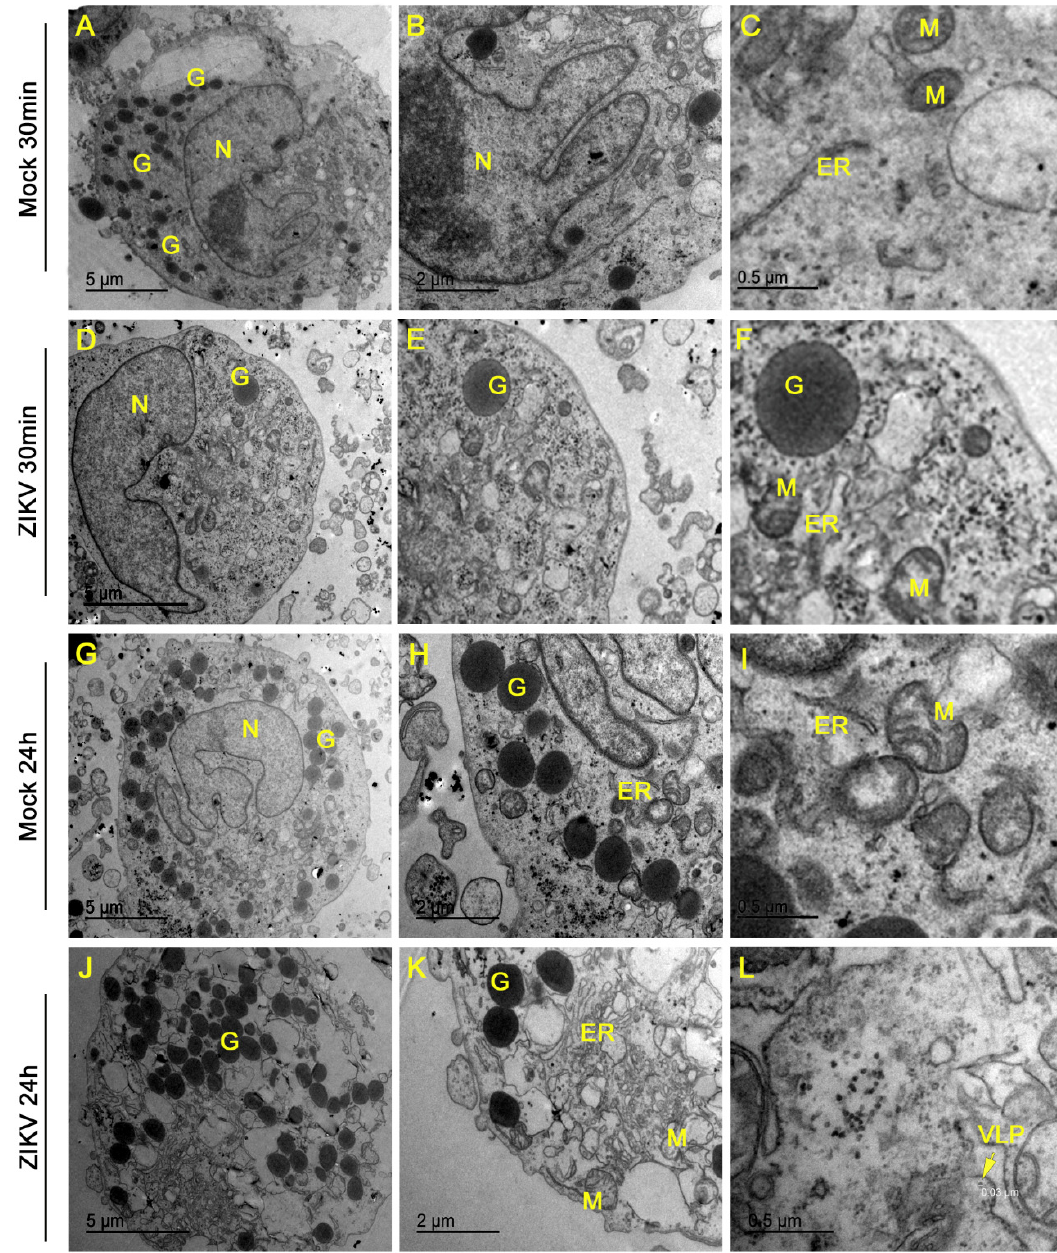
Figure 5. Ultrastructural changes in HMC-1 mast cells infected with ZIKV. HCM-1 cells were exposed to ZIKV or mock for 30 min or 1 h with a post 24 h incubation before processing and imaging